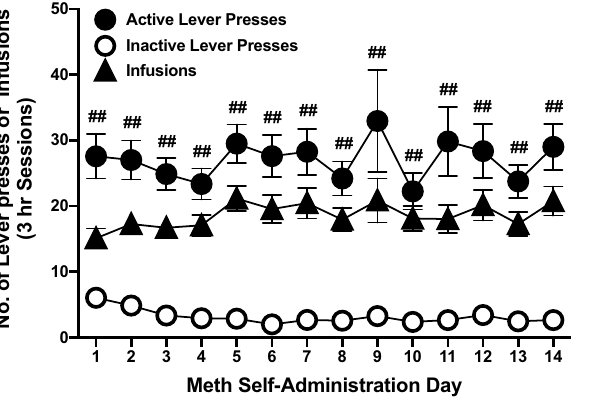
Figure 3. Methamphetamine (meth) self-adminsitration operant task. Meth self-administering rats (n = 42) readily acquired the operant lever pressing task. There was a significant difference between the active and inactive lever presses throughout the operant task. Repeated measures ANOVA followed by a Bonferonni’s post hoc analysis, ## p < 0.01 versus inactive presses.